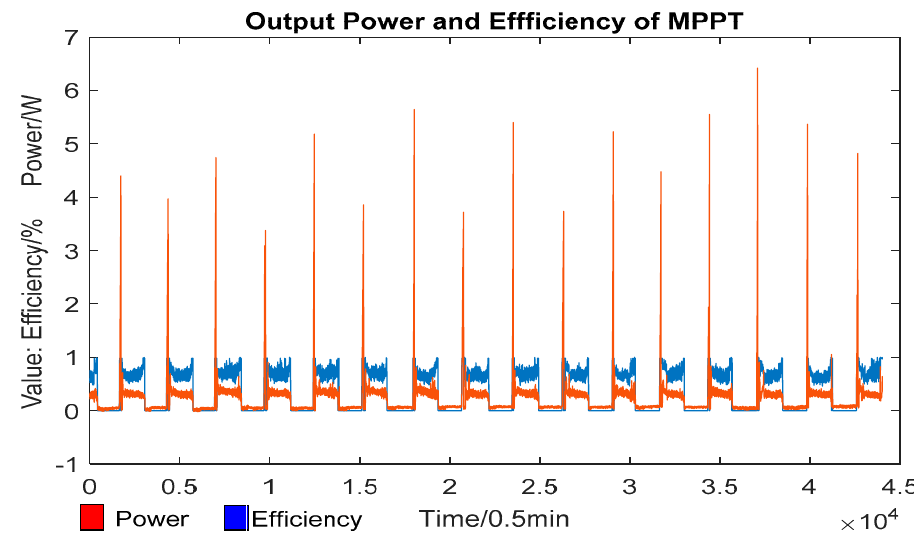
Figure 23. Output power and efficiency of maximum power point tracker (MPPT).